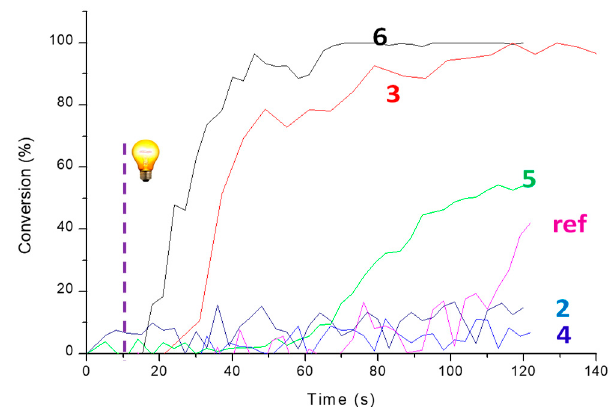
Figure 3. Photopolymerization profiles (epoxy function conversion vs. irradiation time) measured by RT-FTIR for the photoinduced polymerization using the different iodoniums ( 2 – 6 ) 1% w / w ; the polymerization profile obtained with the reference is noted ref; thick samples (1.4 mm) under air, upon LED@365 nm irradiation (the irradiation starts at t = 10 s, 500 mW/cm 2 ).